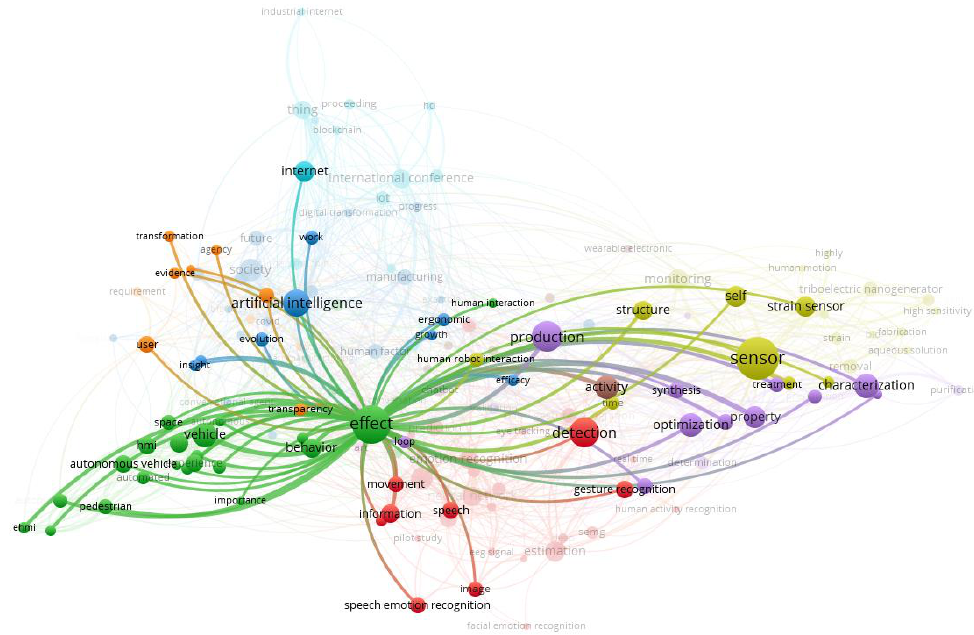
Figure 18. Effect Figure 18. Effect dependency. Figure 18. Effect dependency.